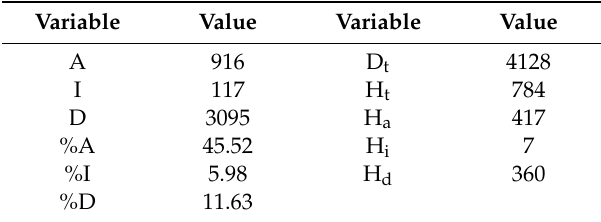
Table 3. Values of the calculated statistical significance